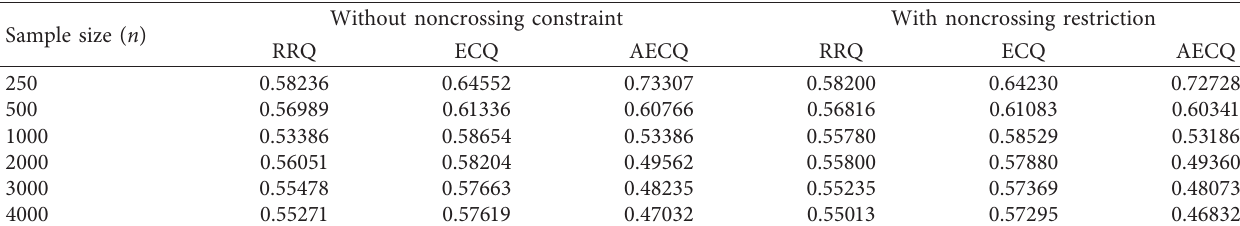
Table 3: ARMSE for 􏽢 μ t, θ , α under different models for θ